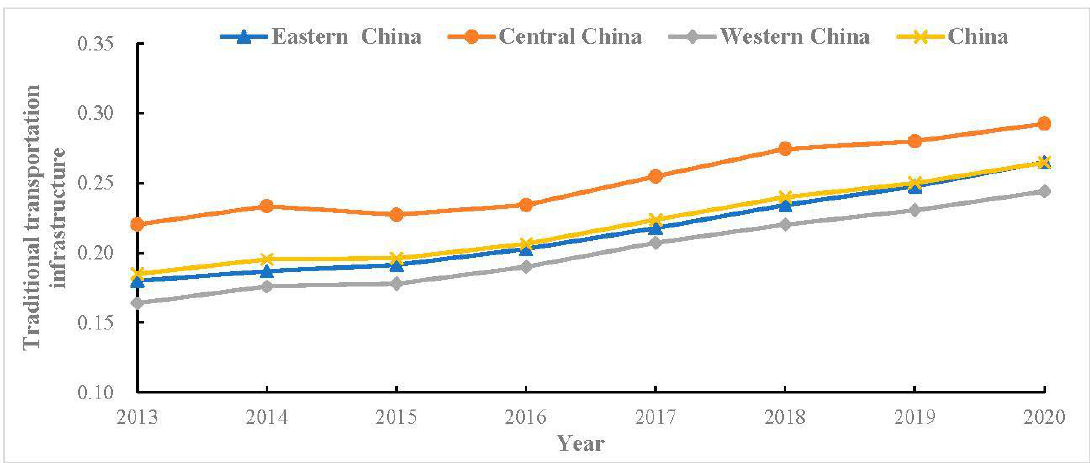
Figure 3. Traditional transportation development in China and three different regions from 2013 to 2020.